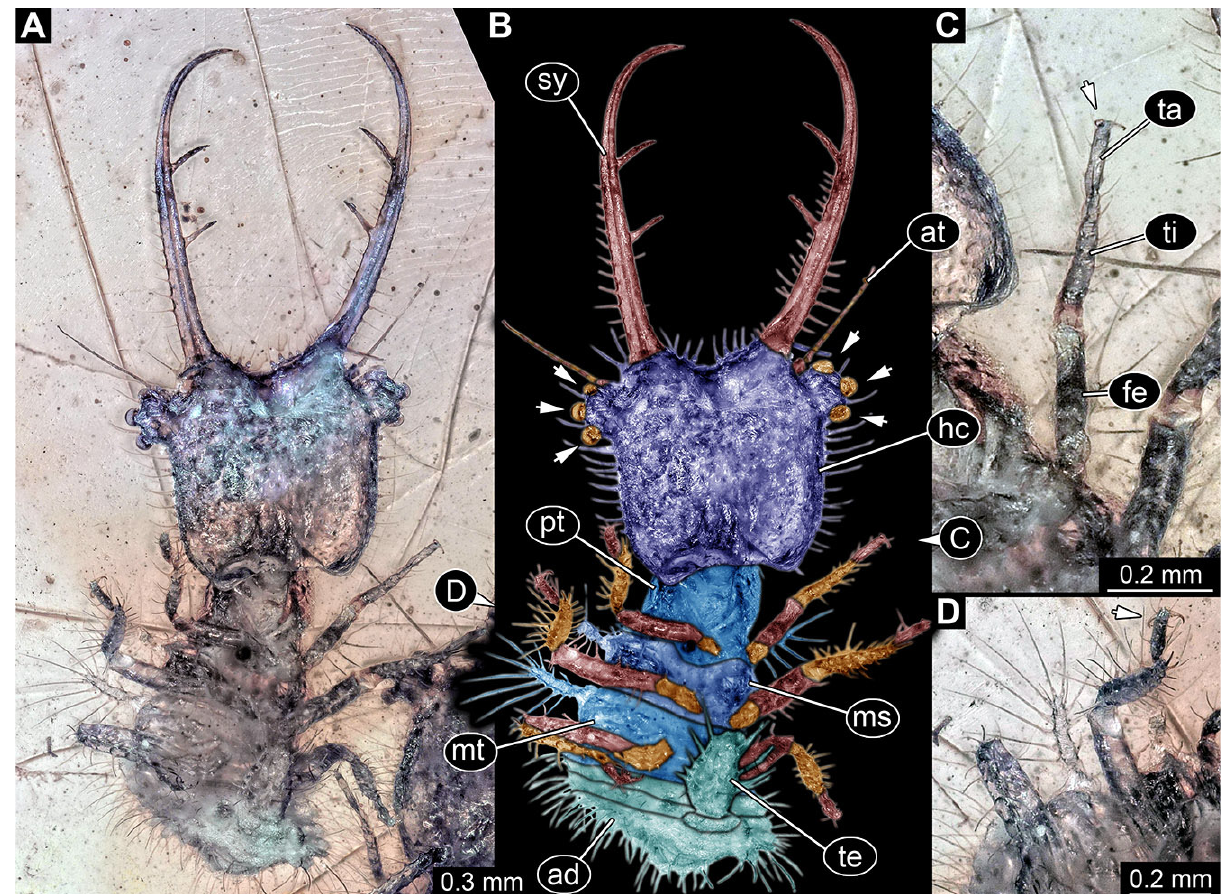
Figure 14. Fossil owllion larva, specimen 3227 (PED 0083a), Cretaceous Kachin amber, Myanmar. ( A ) Overview, ventral. ( B ) Color-marked version of ( A ); arrows point to stemmata. ( C , D ) Close- ups on locomotory appendages with claws (arrows). Abbreviations: ad = abdomen; at = antenna; fe = femur; hc = head capsule; ms = mesothorax; mt = metathorax; pt = prothorax; sy = stylet; ta = tarsus; te = trunk end; ti = tibia.